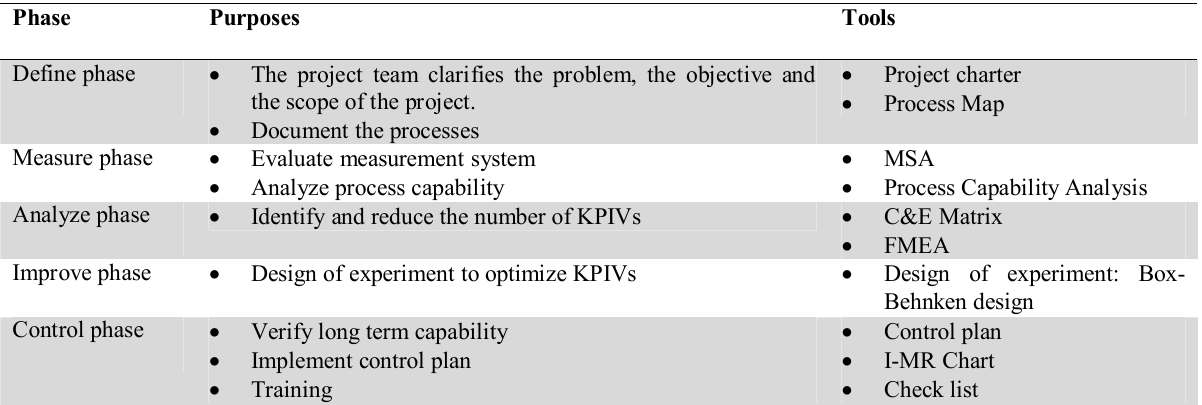
The DMAIC steps of Six Sigma